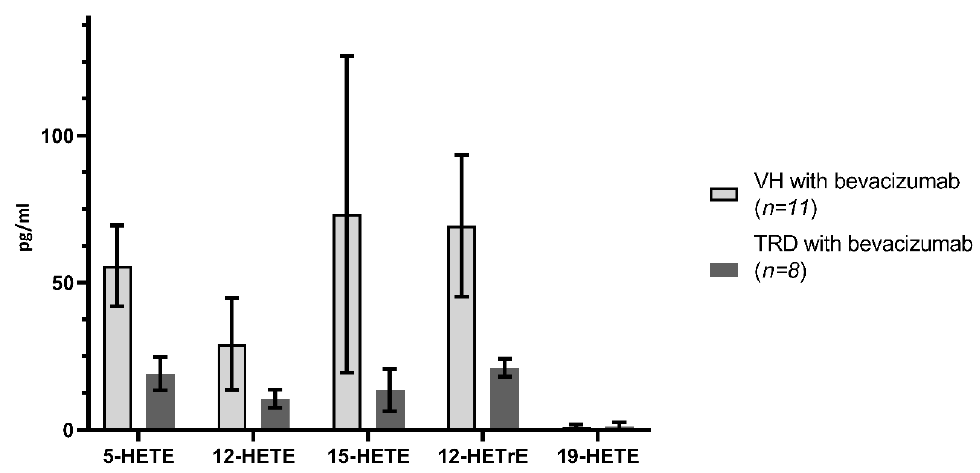
Figure 5. Human vitreous levels of eicosanoids in PDR subtypes treated with bevacizumab, VH ( n = 11) vs. TRD ( n = 8) eyes. Comparison of levels (pg / mL) of 5-HETE, 12-HETE, 15-HETE, 12-HETrE, and 19-HETE in VH vs. TRD.